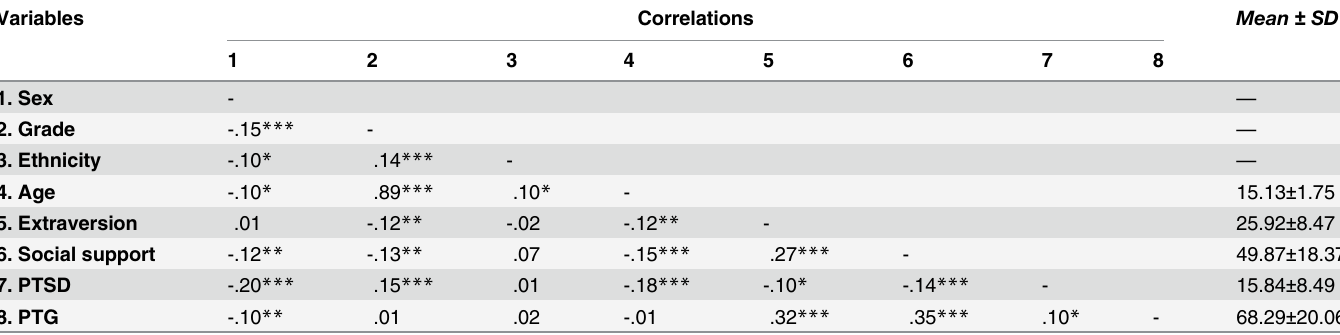
Table 1. The correlations, means, and standard deviations among the main study